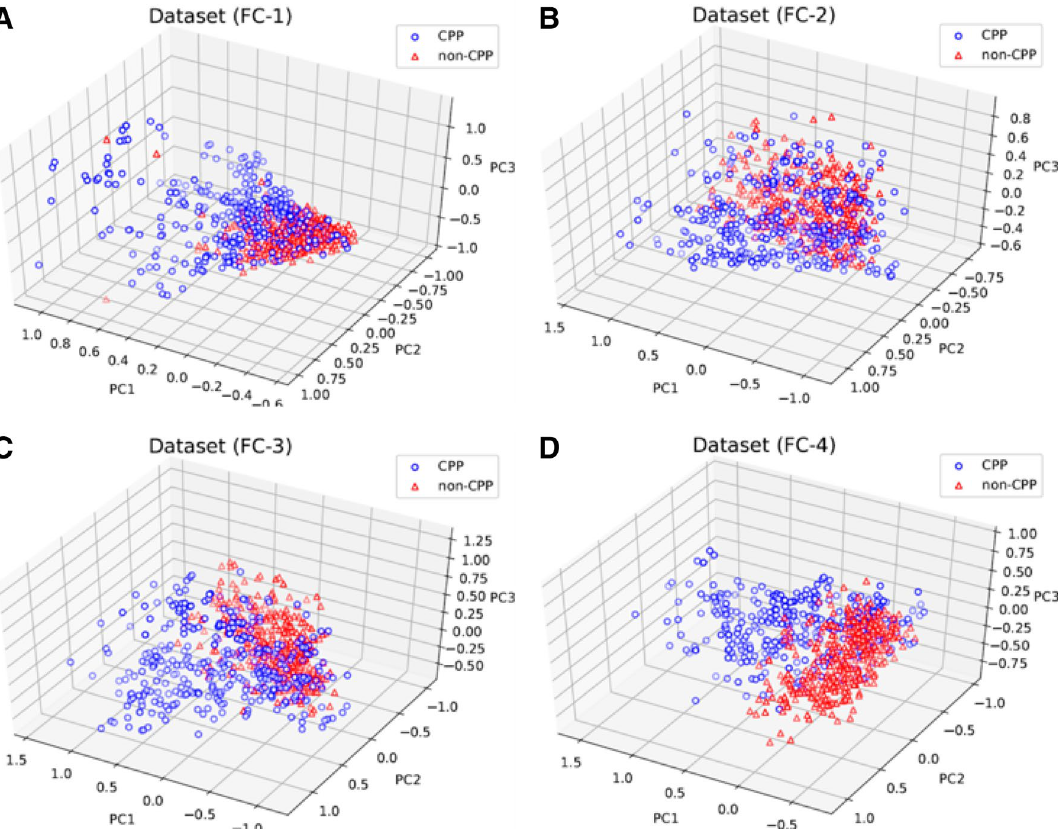
Figure 6. Analysis of 3D dimensionality reduction using PCA of the sequence- and structure-based descriptors present in FC-1 to FC-4. Panel ( A ) 3D PCA of FC-1 showing a contribution of explained variance ratio of 10.93% (PC1), 7.26% (PC2), and 6% (PC3), and cumulative explained variance ratio (CEVR) of 24.19%. ( B ) 3D PCA of FC-2 showing a contribution of explained variance ratio of 48.9% (PC1), 21.94% (PC2), and 14.34%(PC3), and CEVR = 85.19%. ( C ) 3D PCA of FC-3 showing a contribution of explained variance ratio of 16.31% (PC1), 12.03% (PC2), and 7.22% (PC3) and CEVR = 35.58%. ( D ) 3D PCA of FC-4 showing a contribution of explained variance ratio of 17.81% (PC1), 12.48% (PC2), and 8.93% (PC3), and CEVR =